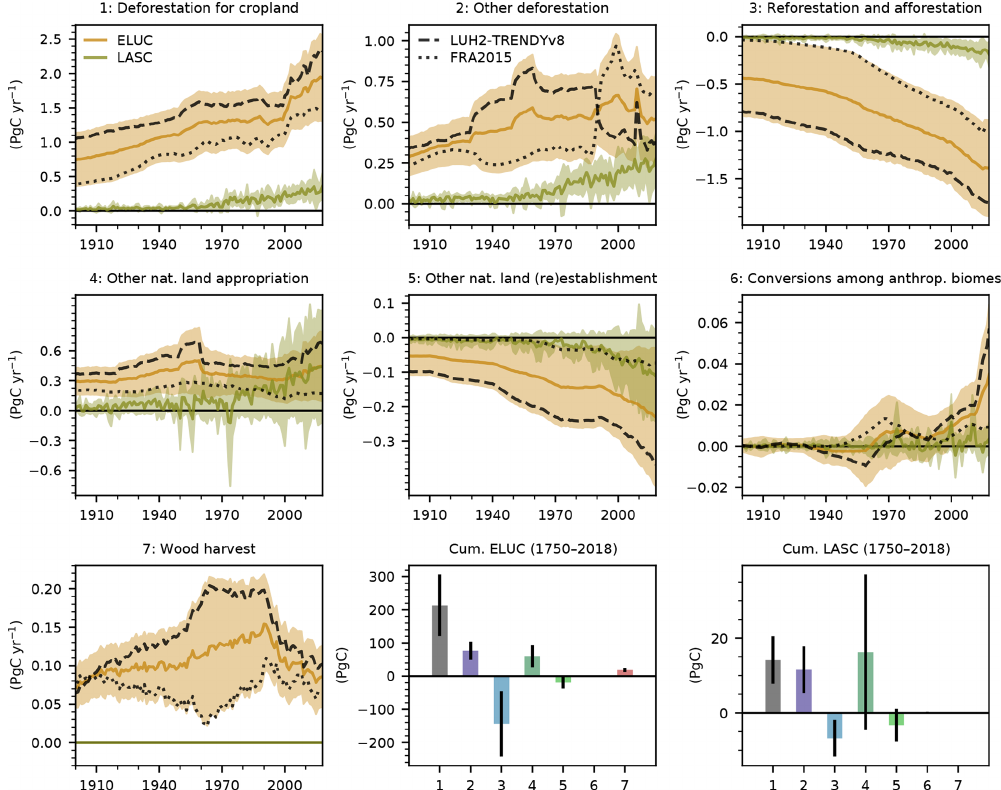
Figure 5. Breakdown of our best-guess estimates by LULCC activities. Annual bookkeeping LULCC emissions (in brown) and LASC (in green) are shown, except in the last two panels that show the regional cumulative bookkeeping LULCC emissions (ELUC) and LASC over the 1750–2018 period. Shaded areas and uncertainty bars represent the 1 σ uncertainty range. Similarly to Fig. 3, we also separate the average estimates for the LUH2-GCB2019 (dashed black line) and FRA2015 (dotted black line) data sets (which are shown without their own uncertainty for